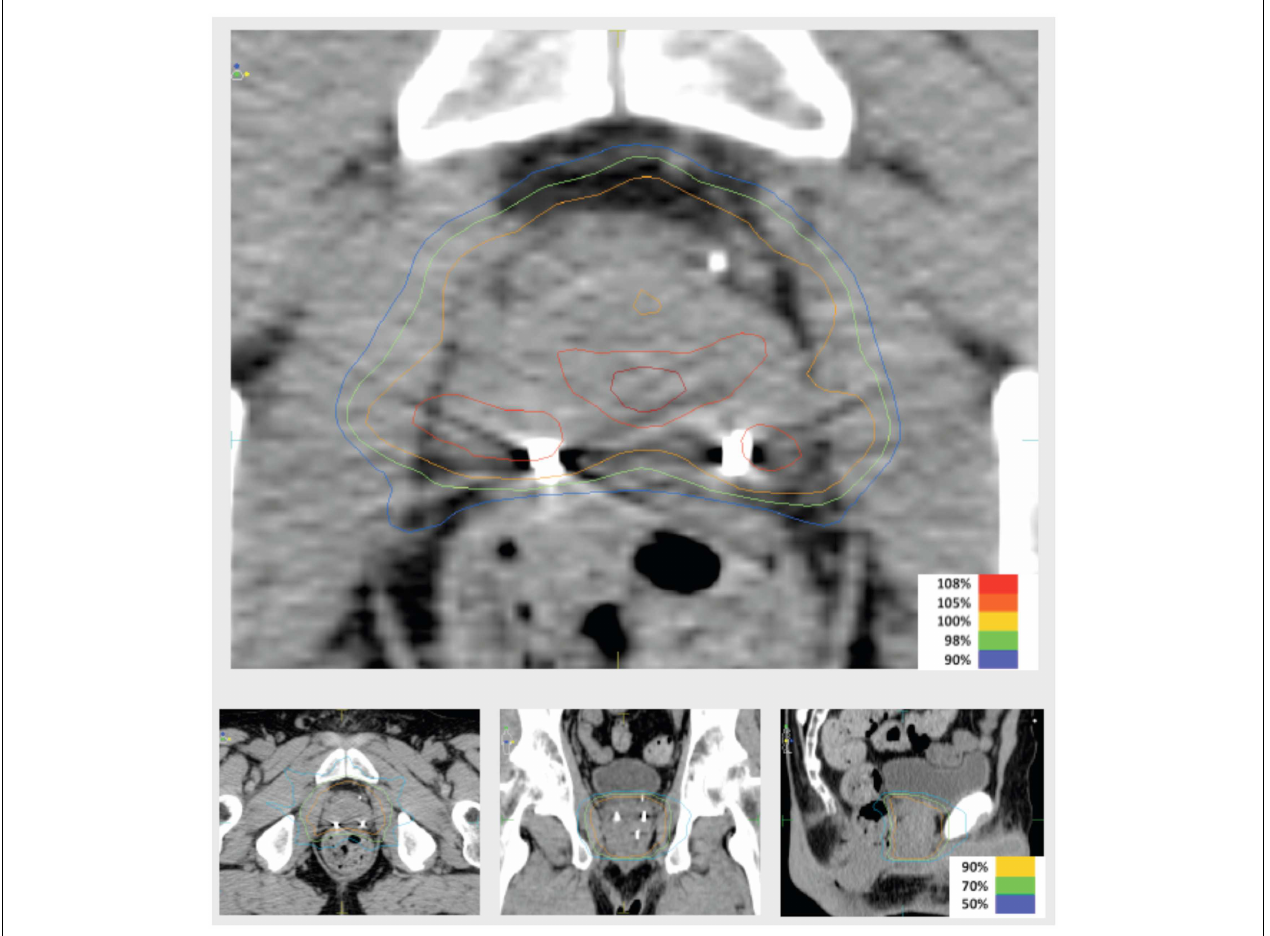
FIGURE 1 | Representative isodose distributions of an SABR treatment plan